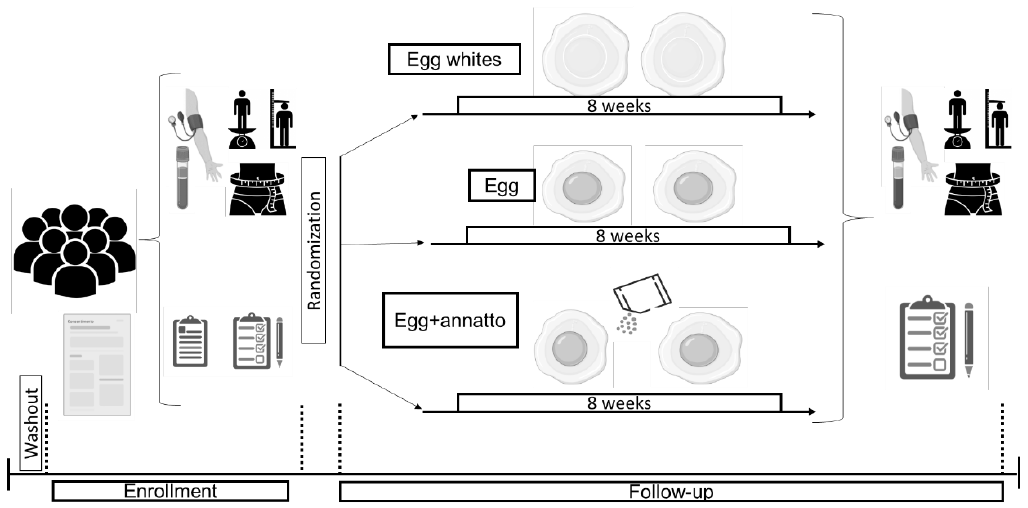
Figure 1. Study intervention protocol.